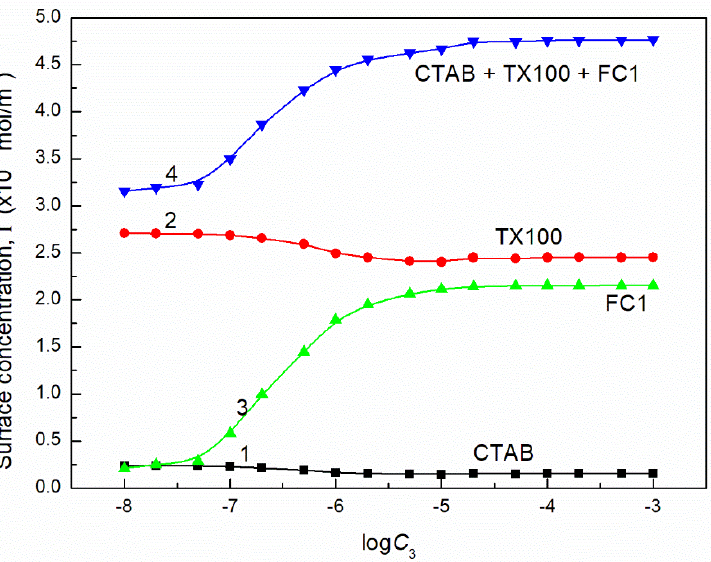
Figure 16. A plot of the concentration of CTAB (curve 1), TX100 (curve 2), FC1 (curve 3) and their sum (curve 4) in the mixed monolayer at the water-air interface formed by the CTAB + TX100 + FC1 mixture at the constant concentration of the binary CTAB + TX100 mixture ( C 12 ) and γ LV = 50 mN/m as well as calculated from Equation (12) based on the contribution of the given surfactant to the reduction of water surface tension vs. the logarithm of the FC1 concentration ( logC 3